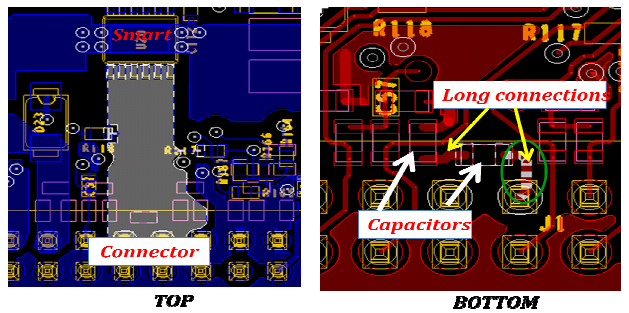
Figure 24: Layout description of the left side.